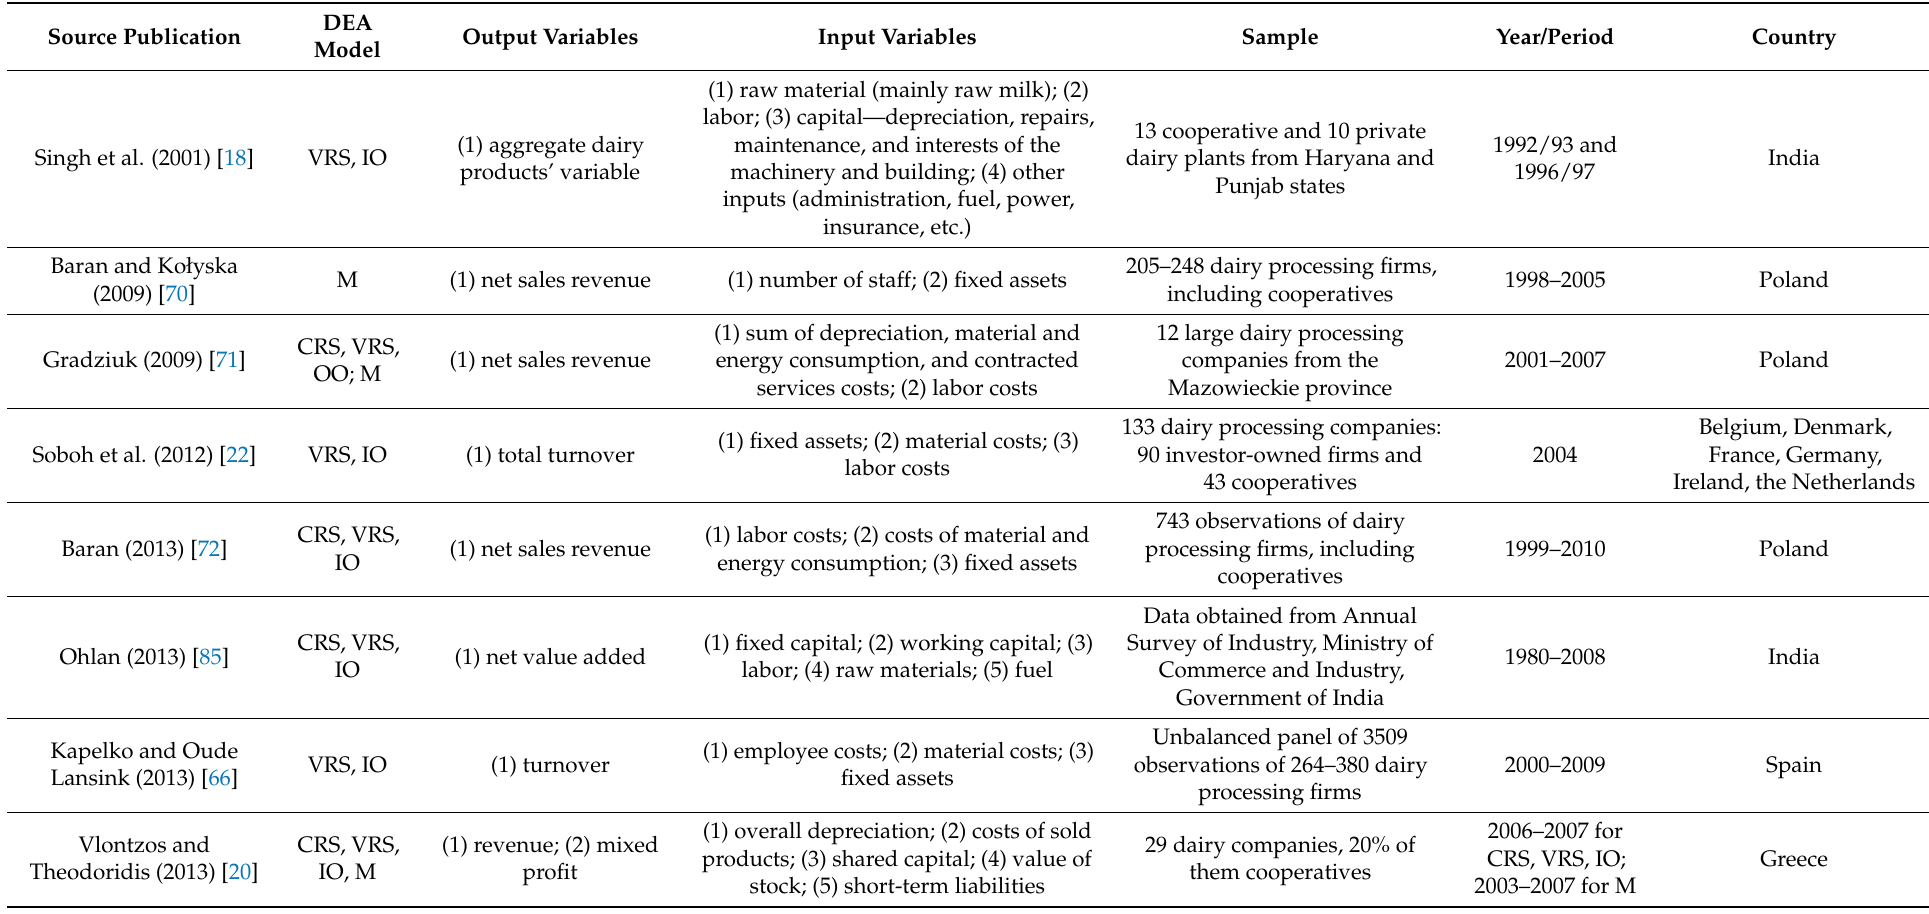
Table A1. Review of literature (authors’ elaboration based on source